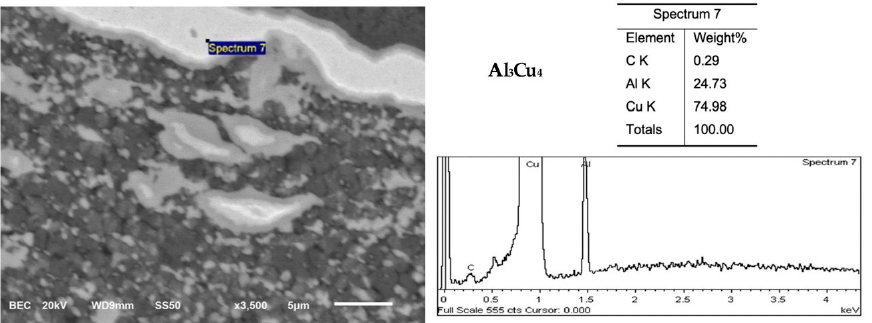
Figure 11. SEM micrographs and EDS of Al 4 Cu 9 found close to the aluminum of base material, the FSW Al6061-Cu was performed at 1000 rpm and 40 mm/min.